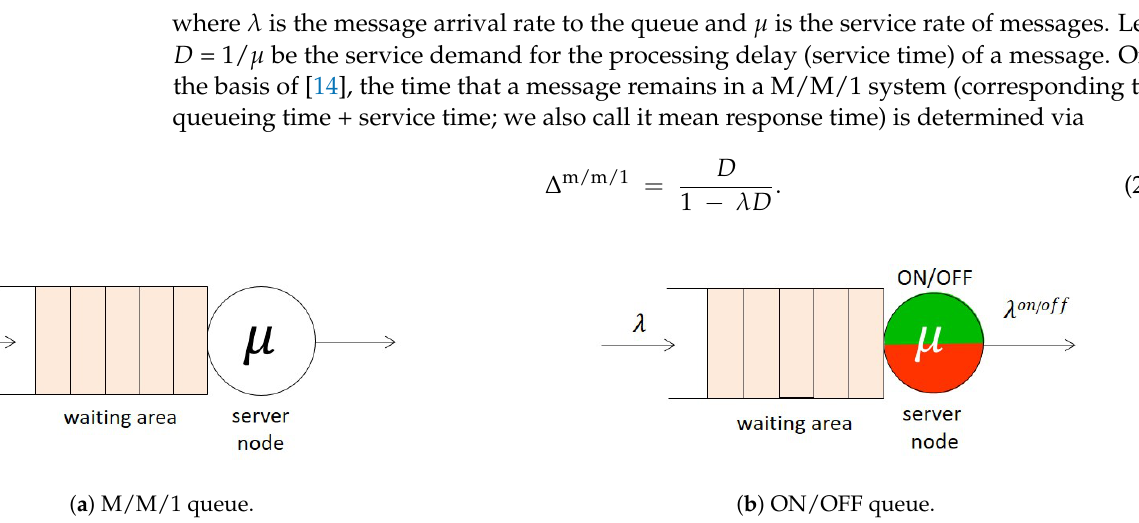
Figure 1. M/M/1 and ON/OFF